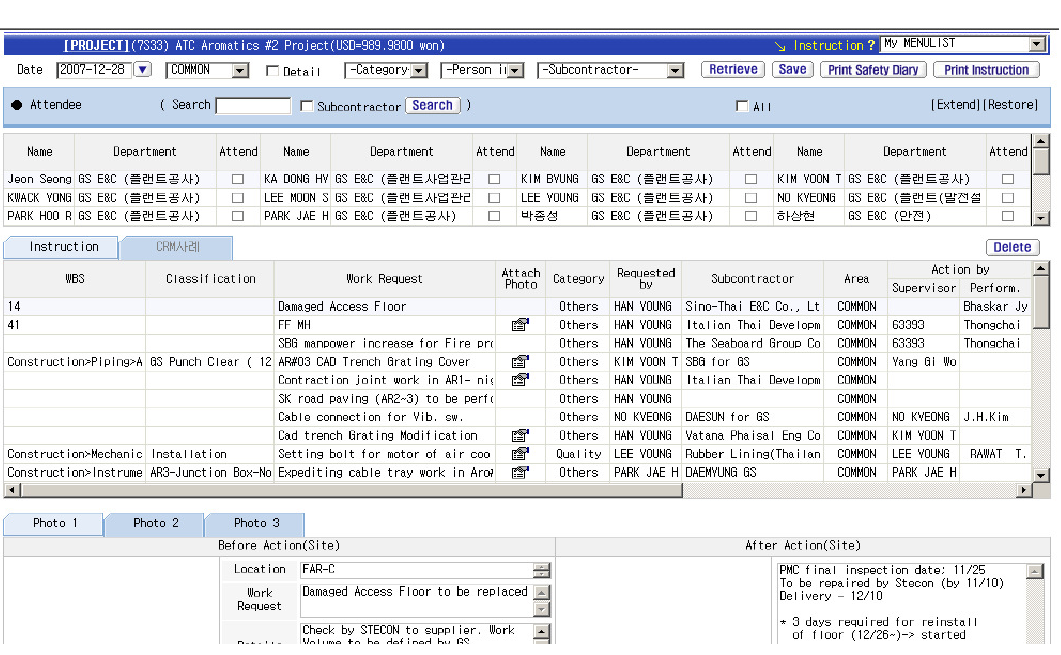
Fig. 6. Task meeting